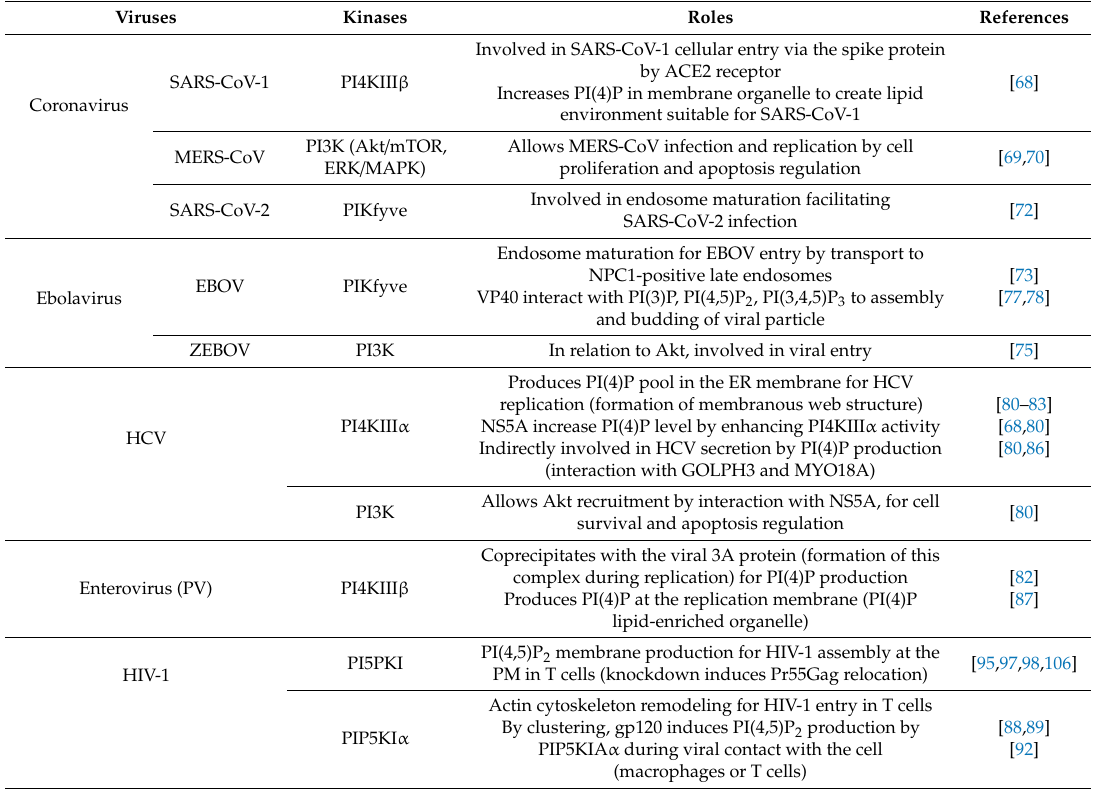
Table 1. Relationships between viruses and the kinases important for their life